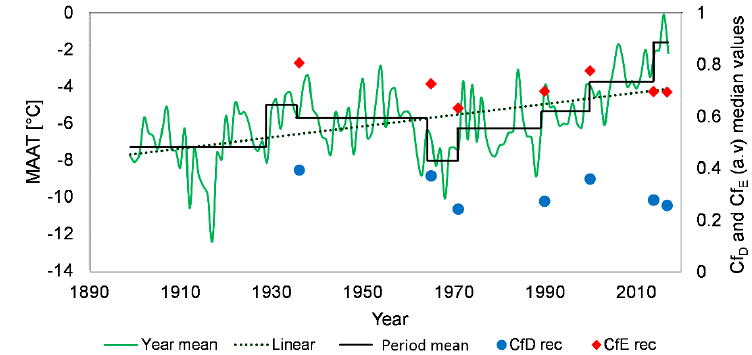
Figure 4. Median values of the CfD and CfE indicators for the selected years of the 1936–2017 period under the background of the mean annual air temperature at the Svalbard Airport (temperature values based on data made available by the Norwegian Meteorological Institute [44].